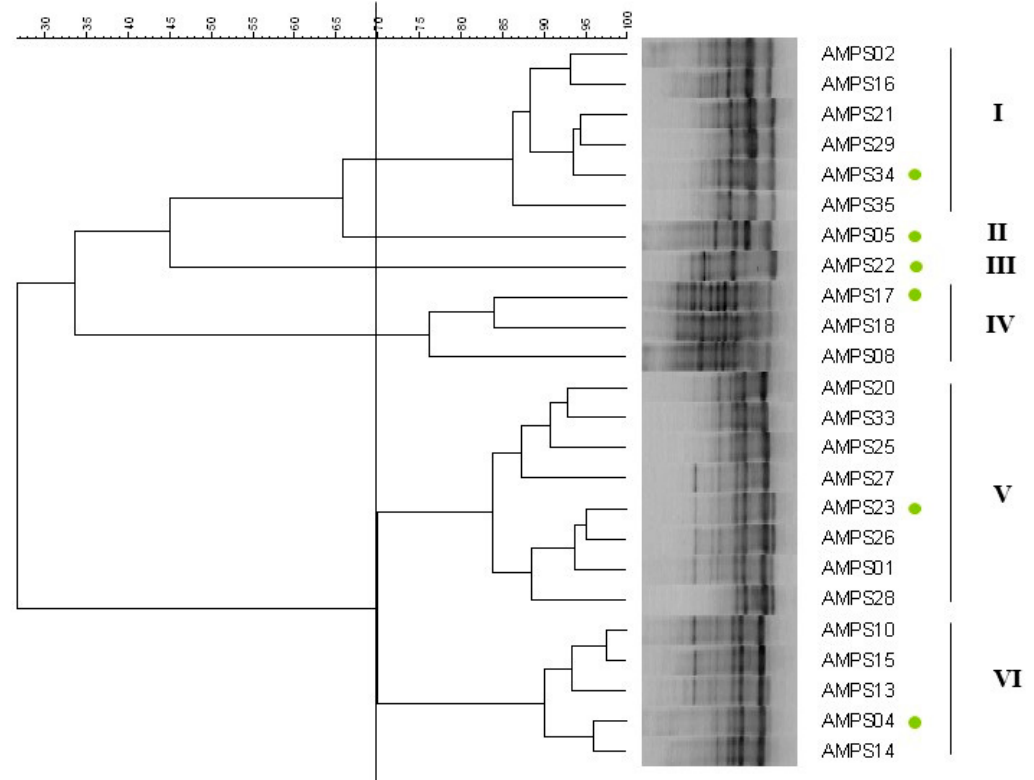
Figure 1. Dendrogram obtained for the strains of this study using Pearson’s coe ffi cient and UPGMA (Unweighted Pair Group Method with Arithmetic Mean) analysis of the RAPD profiles. Filled green circles indicated the strains selected from di ff erent RAPD groups for the remaining analysis of this